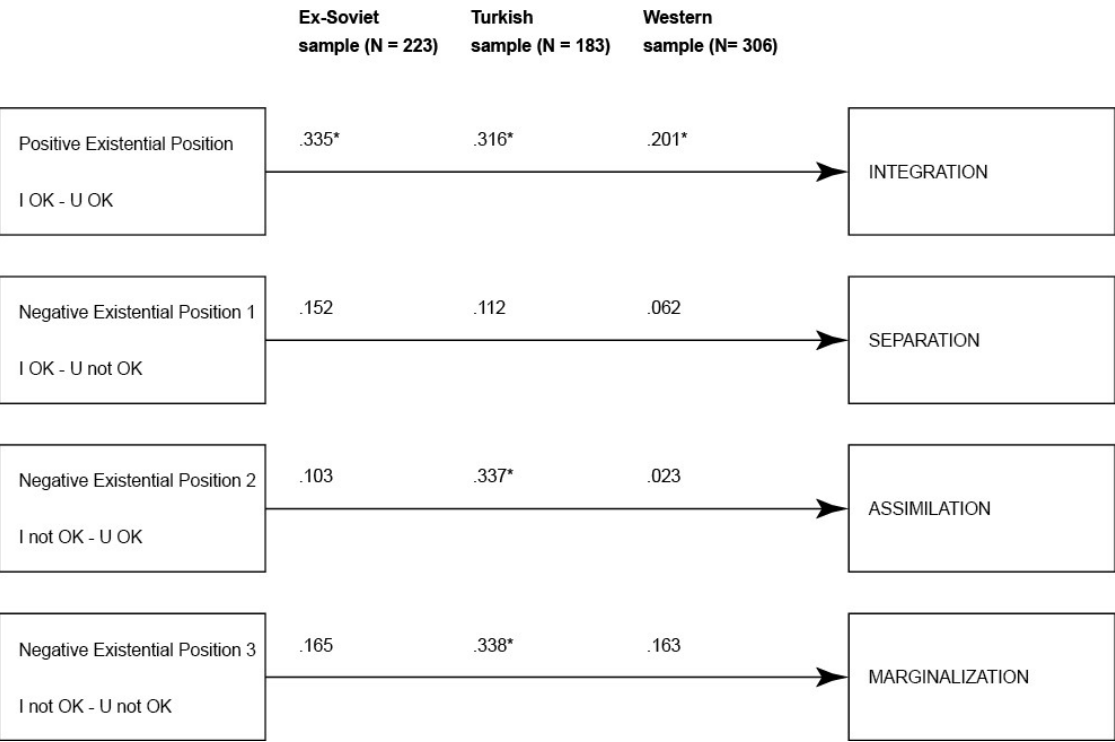
Figure 6: Correlations between Existential Positions and Acculturation Styles among the three subsamples under investigation. * indicates the statistically significant results.